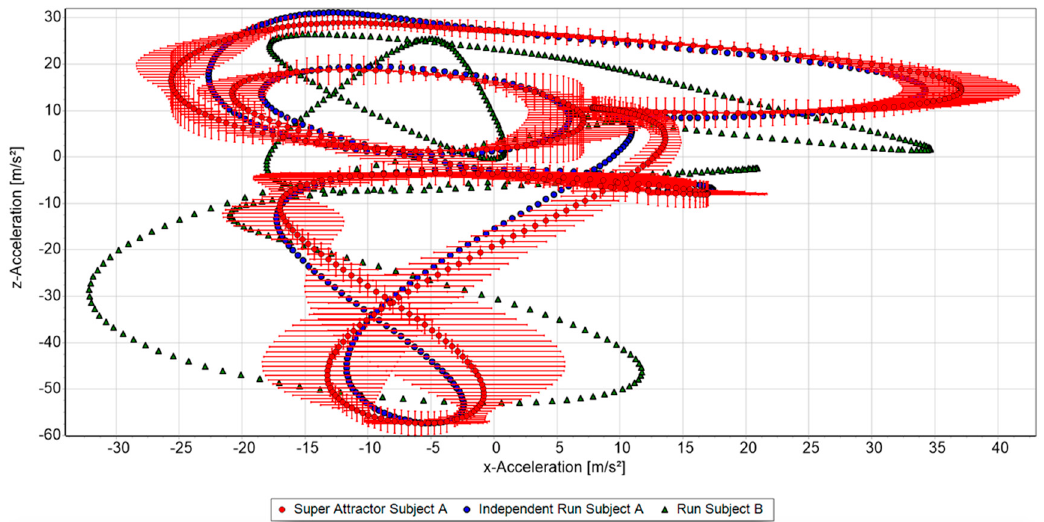
Figure 1. Two-dimensional depiction of the three-dimensional recognition horizon (red) compared to an attractor of the same (subject A, blue) and a different subject (B, green).